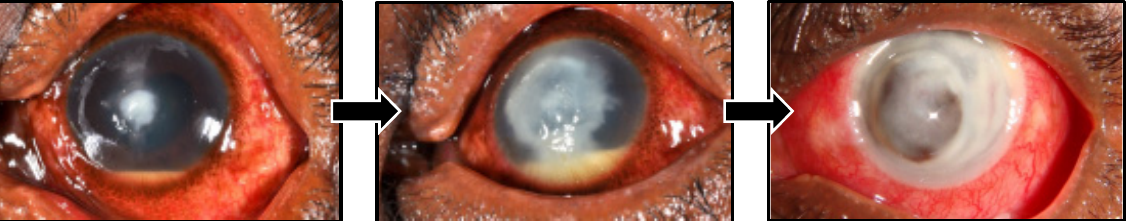
Figure 4. Progression of Fusarium fungal keratitis in a Tanzanian patient despite prompt treatment with topical natamycin 5%. First photograph, baseline presentation; second photograph, progression of infiltrate and increasing hypopyon at one week despite admission and intensive natamycin 5% treatment; third photograph, corneal perforation at three weeks following presentation.